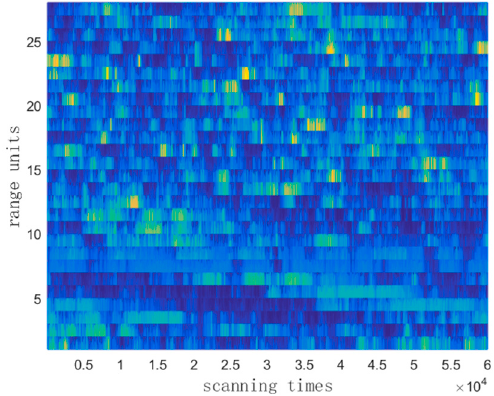
Figure 5. Partial IPIX sea clutter 2D map of HH